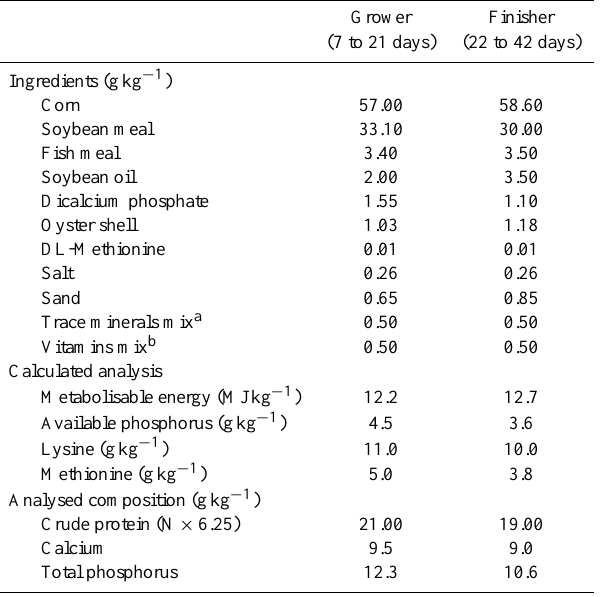
Table 1. The ingredients and chemical composition of the basal diets (gkg − 1 , as fresh